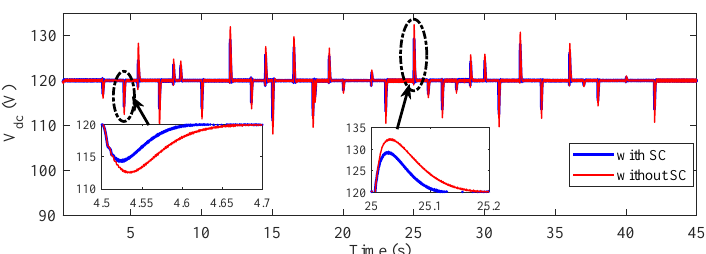
Figure 10. Common DC-bus voltage under varying output power from the PV unit and changing load conditions considering more fluctuations in the solar irradiation.